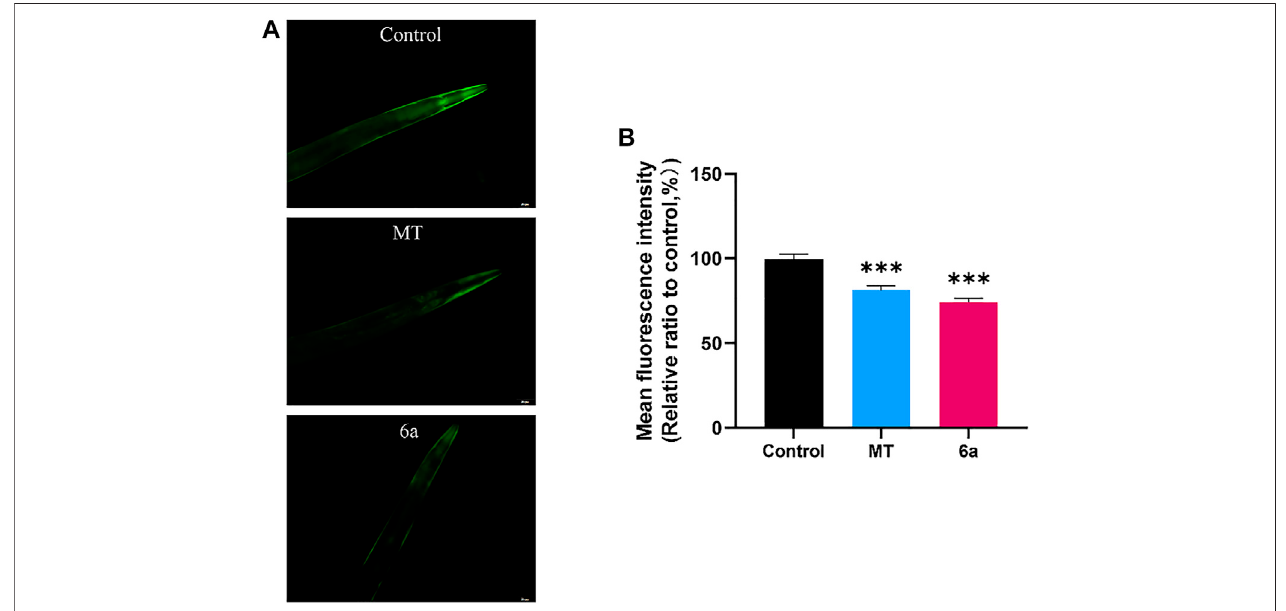
FIGURE5 | α -syn aggregation in NL5901 wasdecreased bytreatmentof MT and 6a. (A) Representative images of α -syn accumulation in different groups ofhead muscles. (B) Quanti fi cation of fl uorescence intensity in NL5901 using ImageJ software (*** p < 0.001).